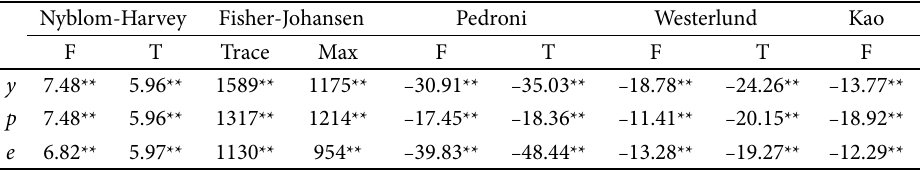
Table 3. Panel cointegration tests results